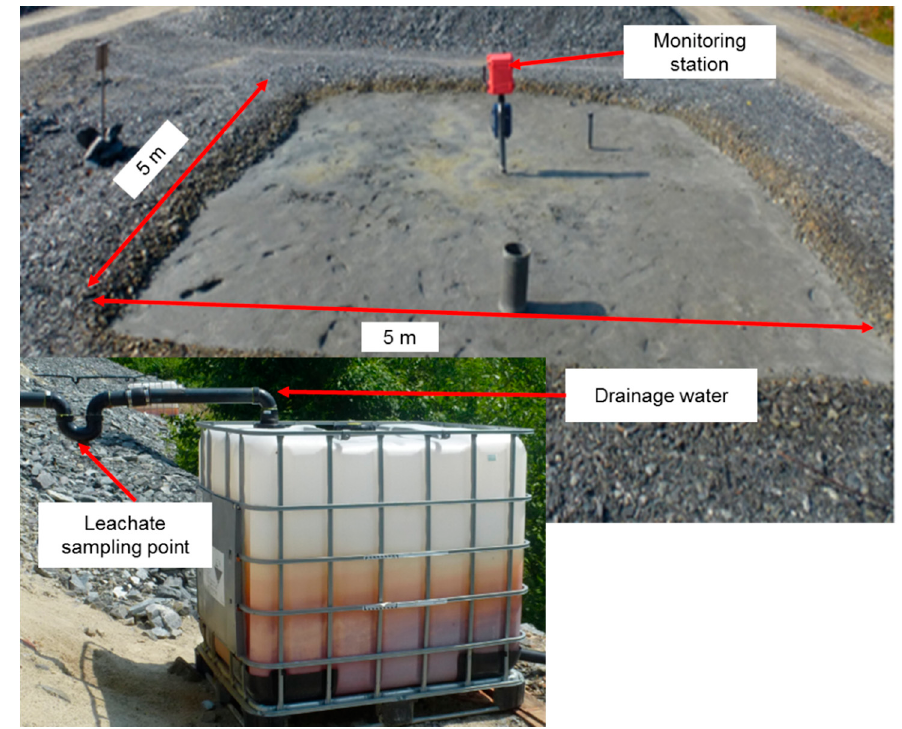
Figure 4. Picture of field experimental cell filled with uncovered reactive tailings.